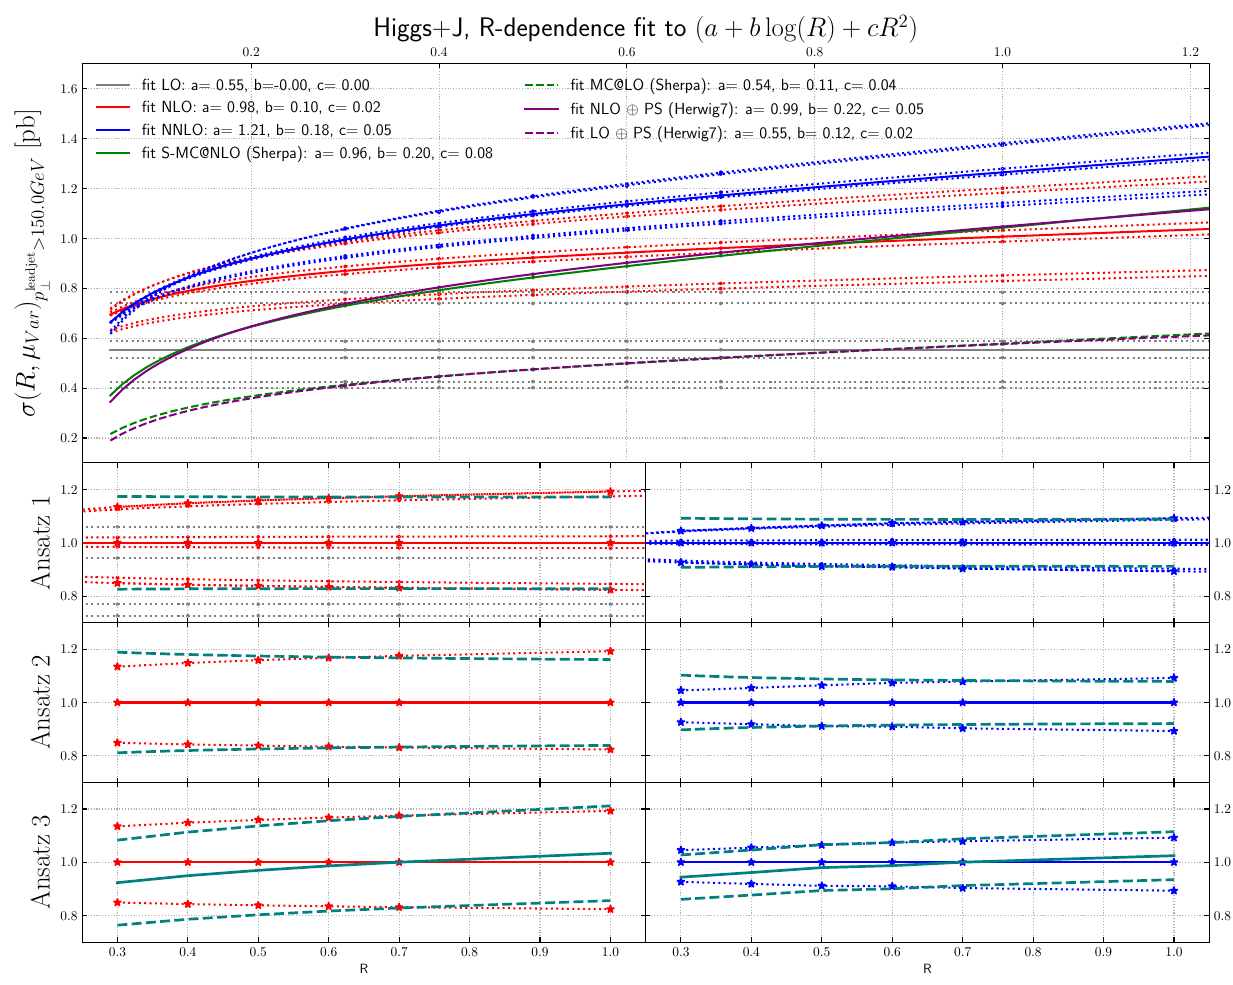
Fig. 7 The R -dependence of the cross sections at NLO, NNLO and NLO + PS are shown, for particular scale values, as a function of the jet radius, for H + ≥ 1 jet production, for leading jet transverse momenta above 150 GeV